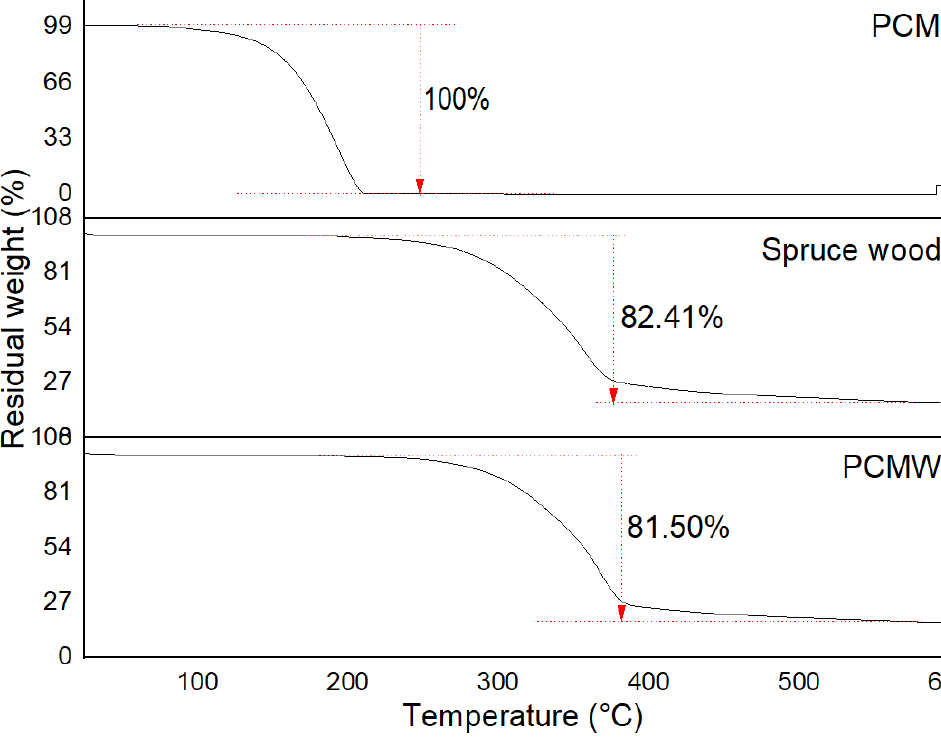
Figure 5. DTG of the PCM (n-HD)- and PCM-impregnated wood (PCMW). The XRD diffraction graph of spruce wood and PCMW is given in Figure 6. The dif- fraction peaks of spruce wood were found at 17.0°, 21.84°, 24.64°, 33.98° and 43.98°. These characteristic peaks represent the crystal structure of cellulose in wood samples. The peaks obtained in 33.98° and 43.98° differ from the literature [35]. This may be due to